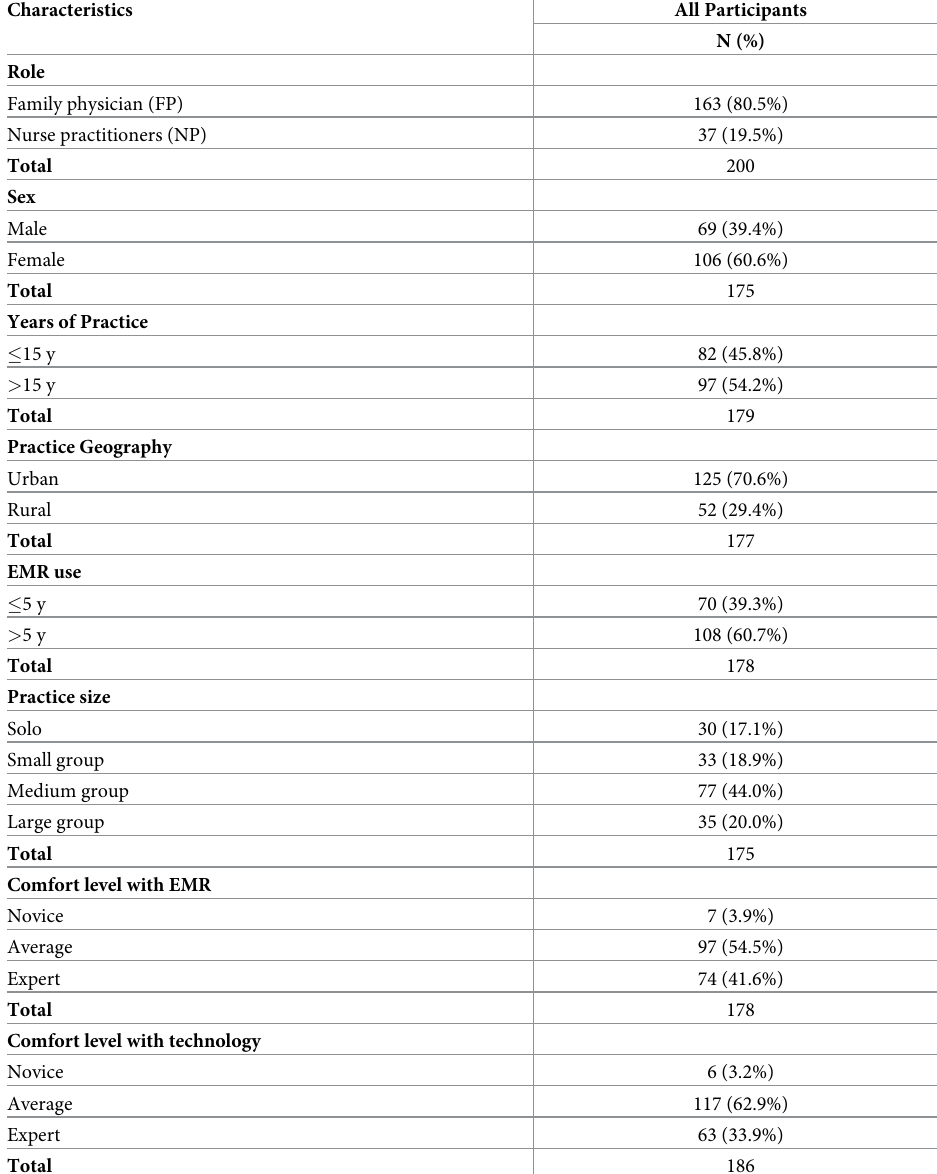
Table 1. Characteristics of